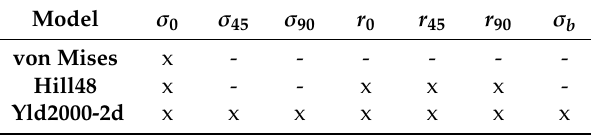
Table 1. Input parameters for yield locus